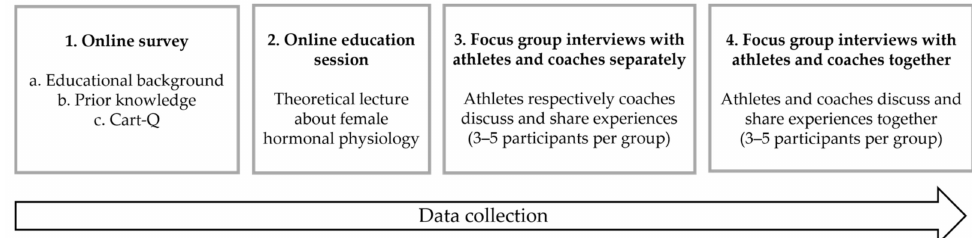
Figure 1. The four sequential stages of the data